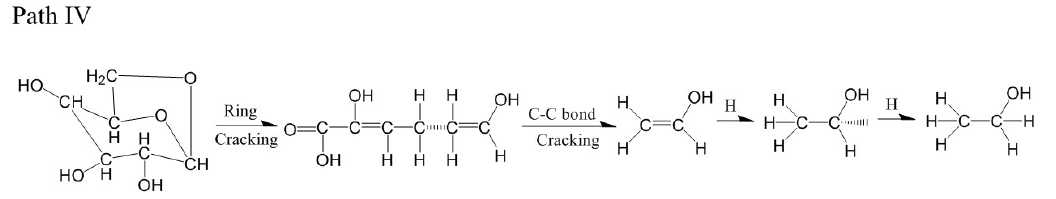
Figure 18. Relevant path IV of ethanol generation at 2600 K.